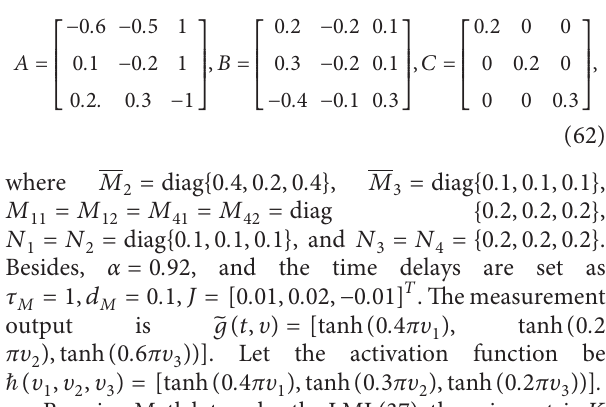
Figure 2: Trajectories of υ